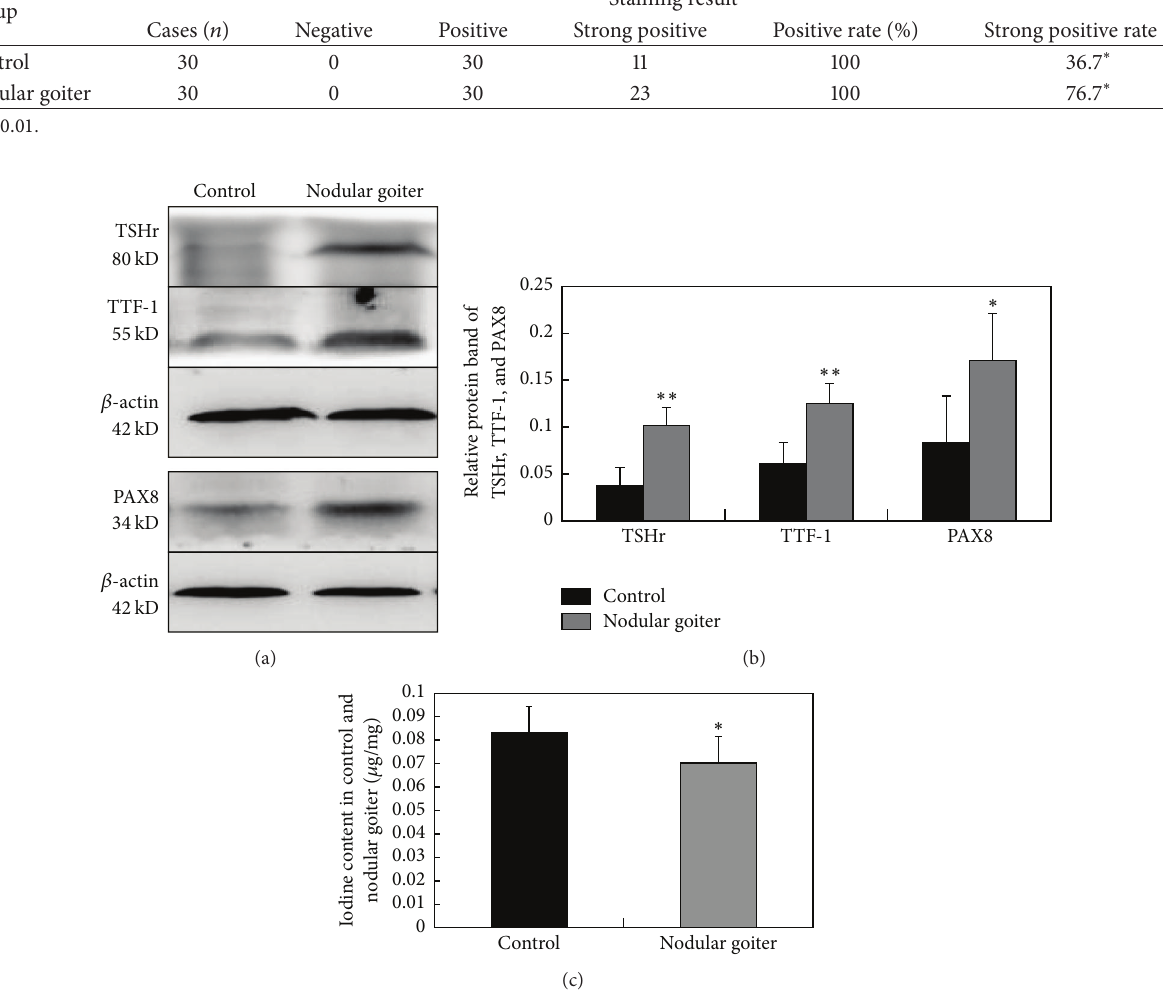
Figure 1: Western blot assay for the expressions of TSHR, TTF-1, and PAX8 protein in nodular goiter and the control; 𝛽 -actin is also detected as an internal control. The expressions of TSHR, TTF-1, and PAX8 in nodular goiter are significantly higher than those in the control. 𝑛 = 10 (a, b). The iodine content ( 𝜇 g/mg) in nodular goiter was significantly lower than those in control tissues. 𝑛 = 30 (c). ∗ 𝑃 < 0.05 ; ∗∗ 𝑃 < 0.01